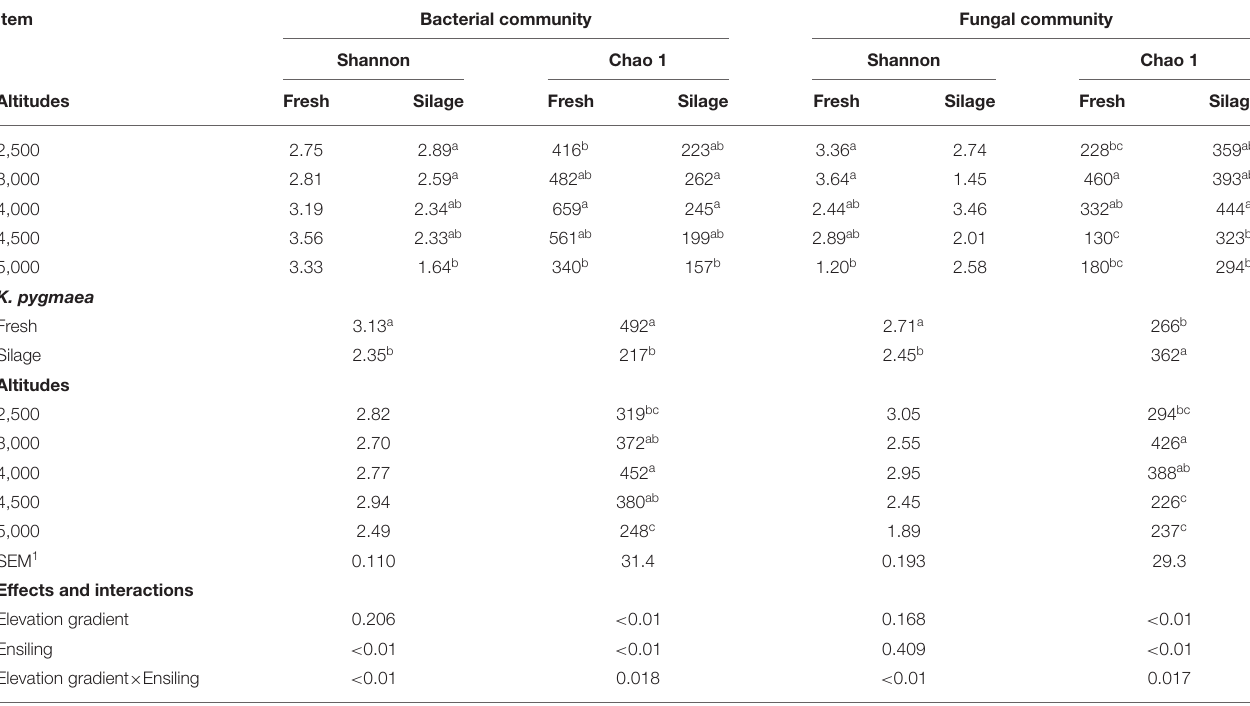
TABLE 4 | The α -diversity indexes of the bacterial and fungal communities of K. pygmaea along the elevation gradient on the Tibetan Plateau. Item Bacterial community Fungal community Shannon Chao 1 Shannon Chao 1 Altitudes Fresh Silage Fresh Silage Fresh Silage Fresh